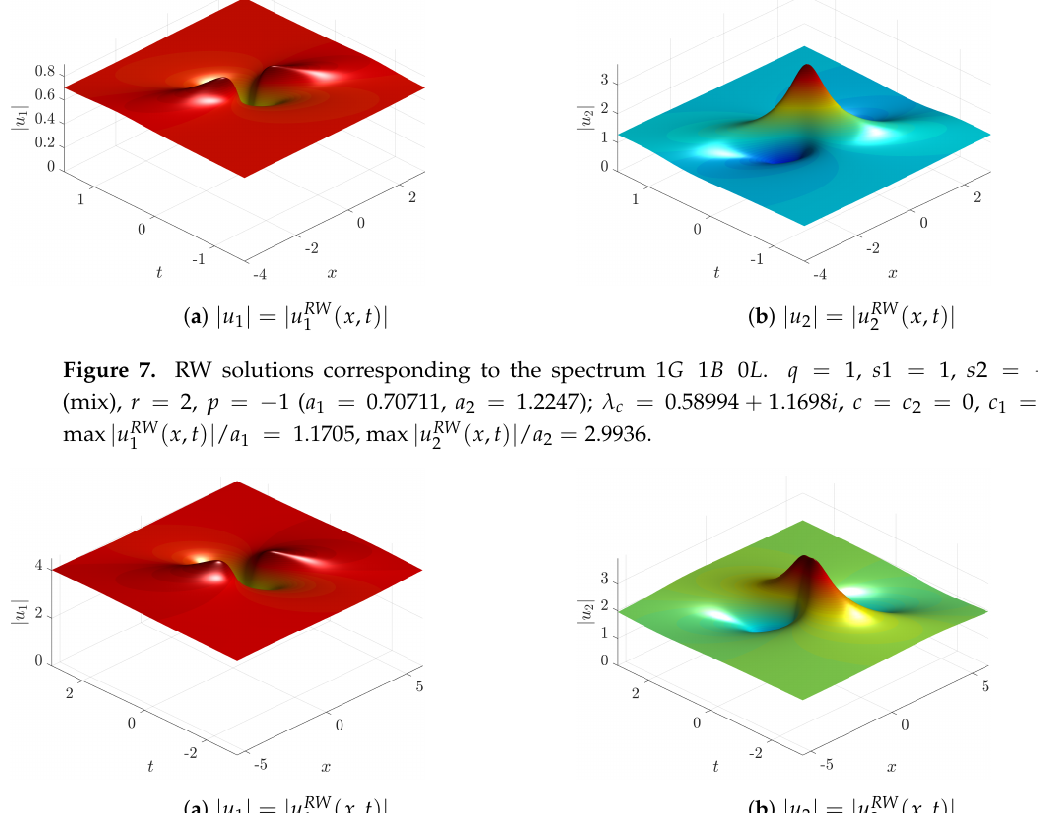
( x , t ) | / a = 1.1193, 1 1